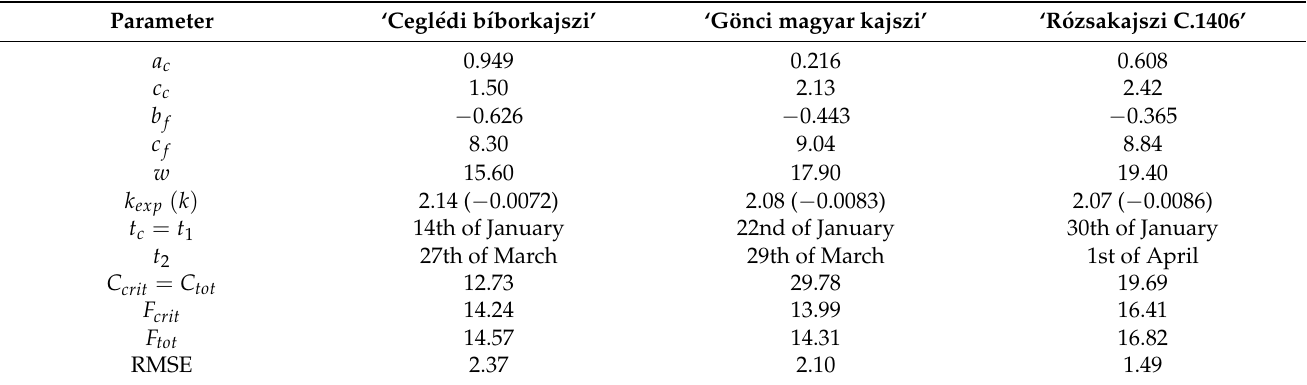
Table 4. The values of the global optimum parameter vectors of the unified model and the corre- sponding RMSE values for ‘Cegl é di b í borkajszi’, ‘Gönci magyar kajszi’, and ‘R ó zsakajszi C.1406’. ‘Cegl é di b í